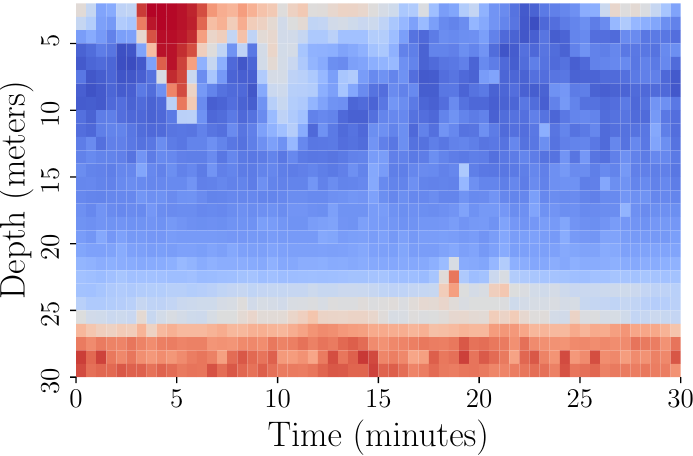
Figure 4. A 30-min frame of observations starting around 15:50 on the 9th of September 2018. It displays a clearly visible wake in the top-left